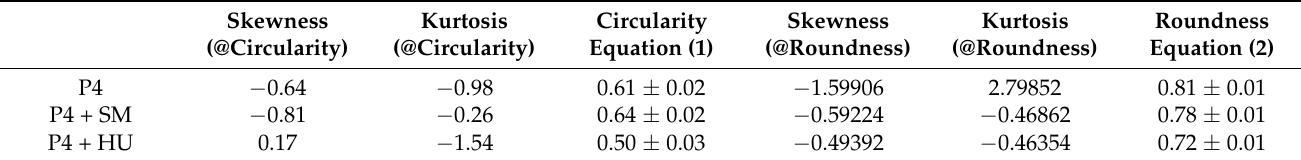
Table 1. Summary of morphometric